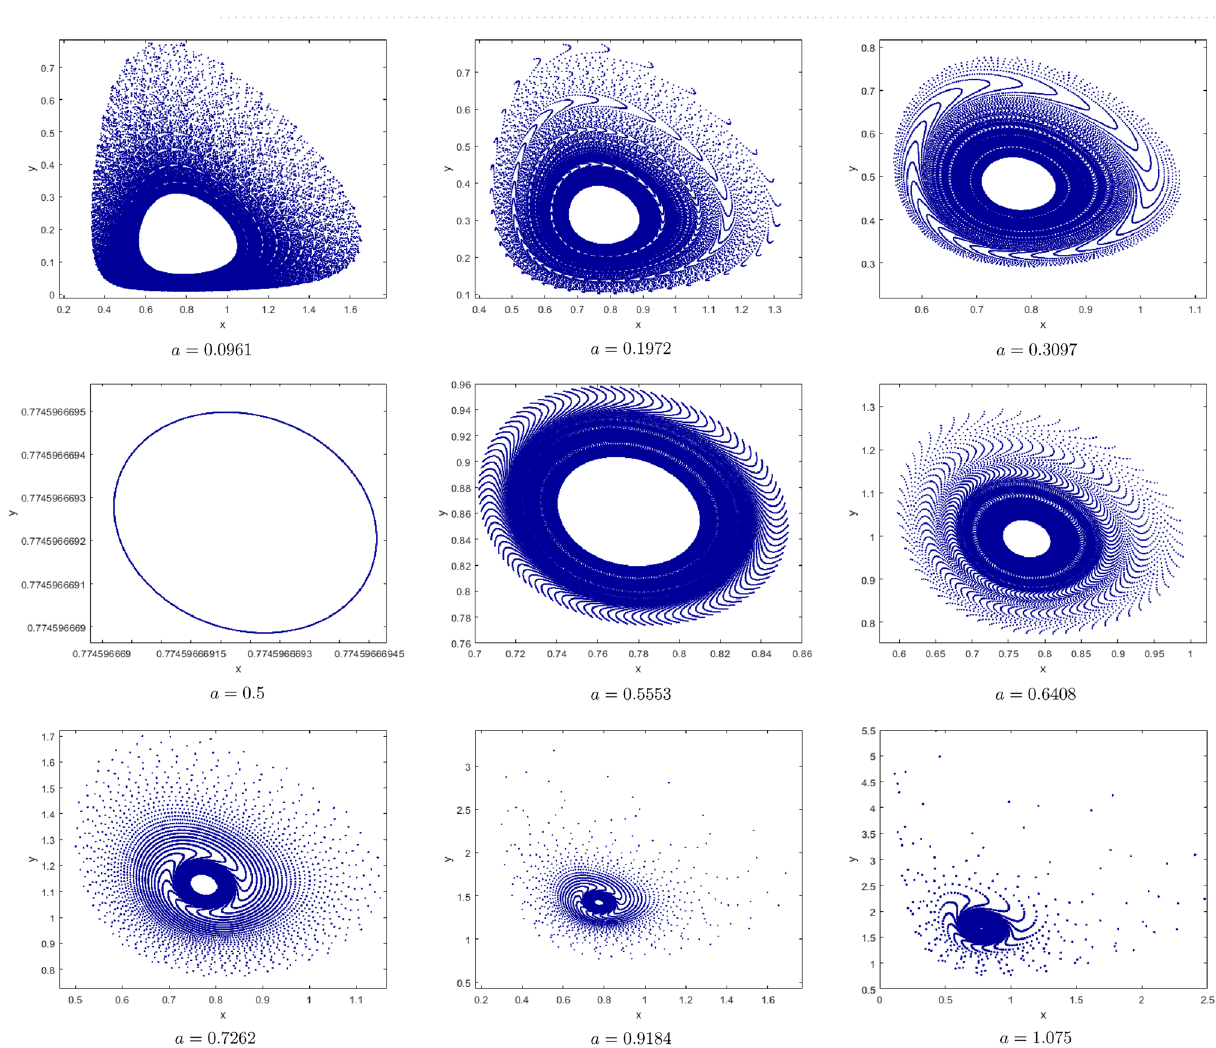
Figure 14. The phase portraits associated with Fig. 13(i),